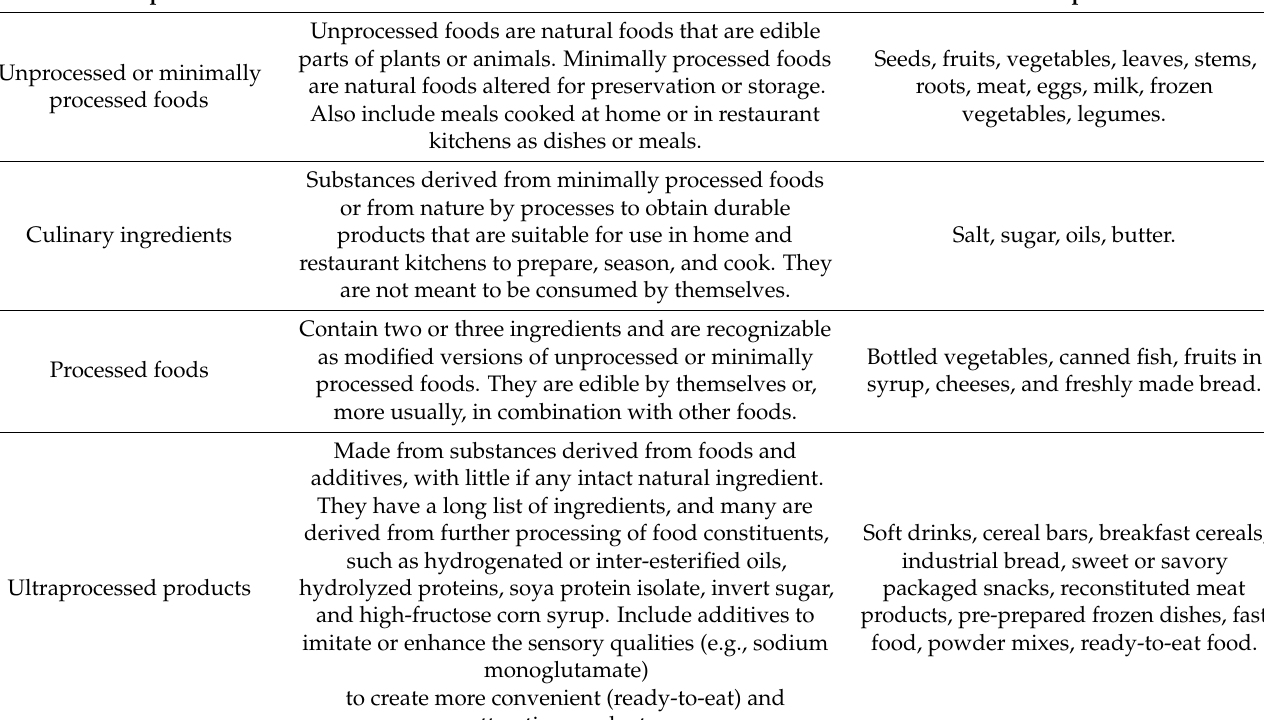
Table 1. NOVA food system classification according to levels of